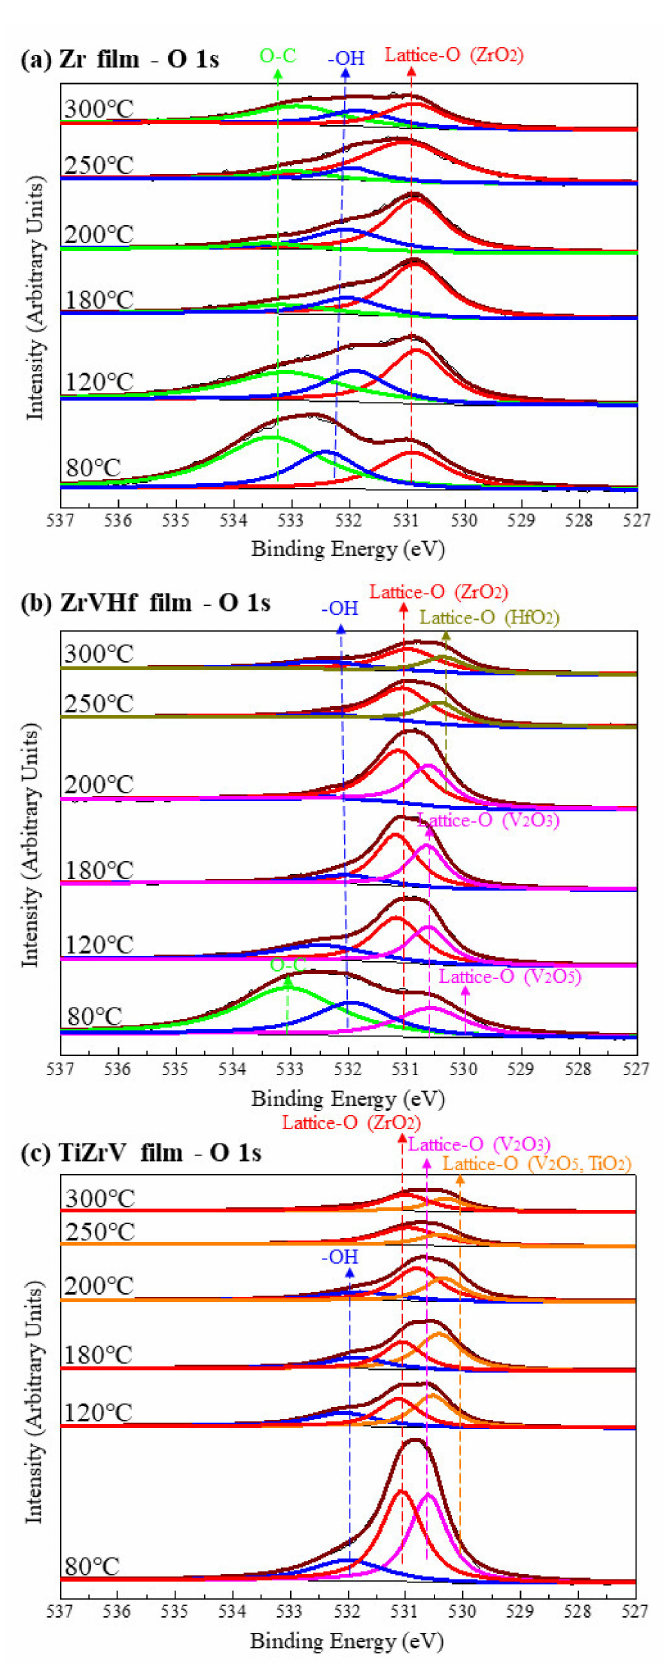
Figure 2. SRPES spectra of the O 1s core-level peaks of ( a ) Zr film, ( b ) ZrVHf film and ( c ) TiZrV film recorded after heating at various